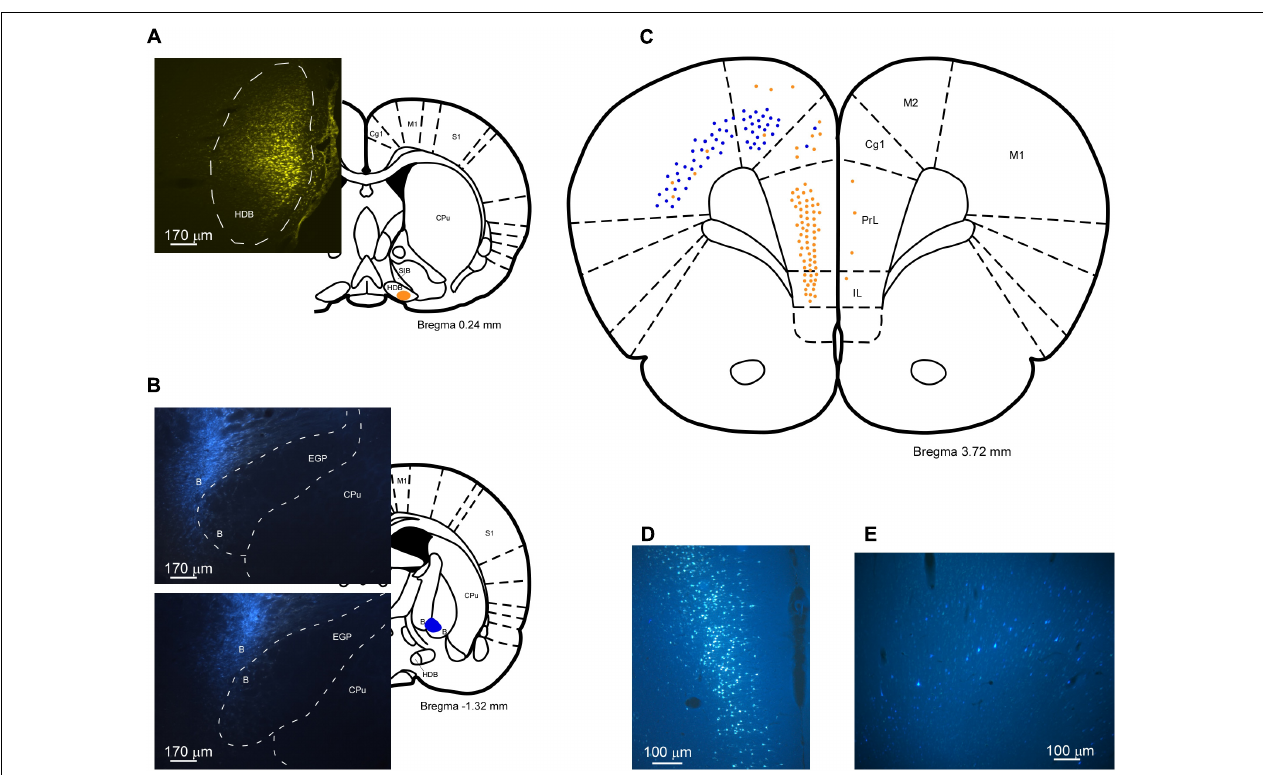
FIGURE 9 | (A,B) Schematic drawings and microphotographs of brain coronal sections showing the injection sites in HDB (A) and in B nucleus (B) . (C) Schematic drawing of coronal section at Bregma +3.72 mm showing single-FG (orange), single-FB (blue), and double-labeled (green) neurons. Most of the neurons that project to HDB are located in the PL/IL cortices whereas neurons projecting to B nucleus tend to be located in M2 and anterior cingulate (ACC) cortices. (D) An example of labeled neurons in PL/IL cortices is shown. (E) An example of neurons labeled in M2 cortex is